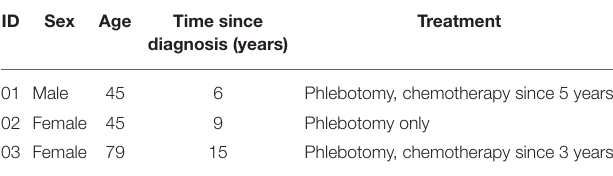
TABLE 1 | Details about three clinical patients used in 2.3.1. TABLE 2 | Parameter sets of subjects from Tetschke et al. (2018) with five in silico parameters λ PV = λ i for each subject as detailed in Section